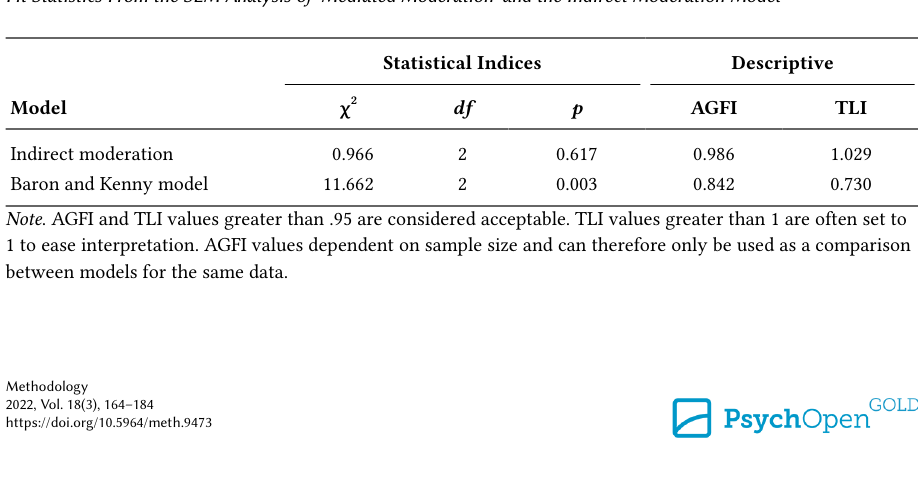
Fit Statistics From the SEM Analysis of 'Mediated Moderation' and the Indirect Moderation